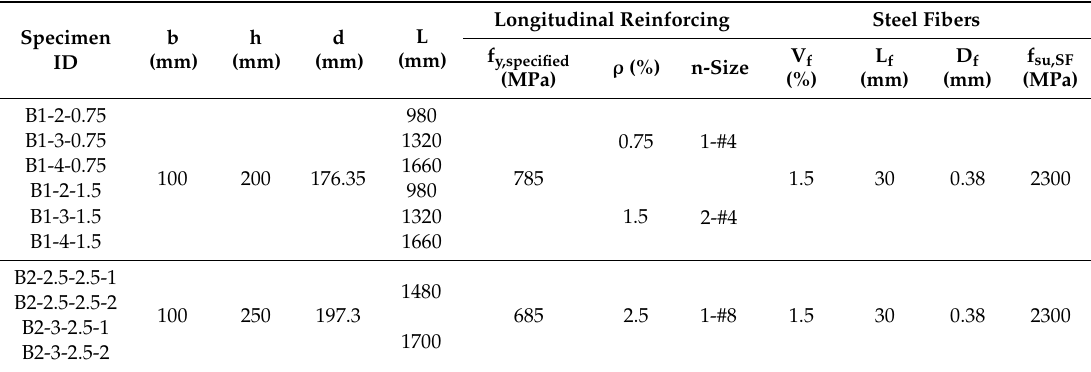
Table 2. Details of specimen